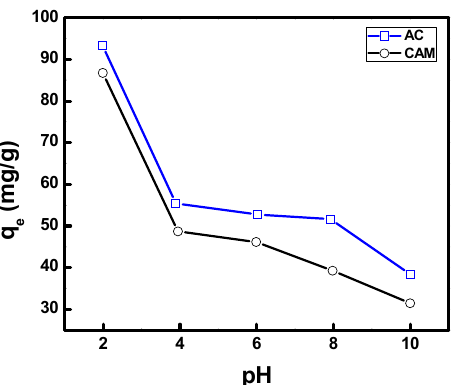
Figure 5. Effect of pH on the adsorption capacity at 25 °C and a 2,4-D initial concentration of 100 mg /L. Figure 5. E ff ect of pH on the adsorption capacity at 25 ◦ C and a 2,4-D initial concentration of 100 mg / L.